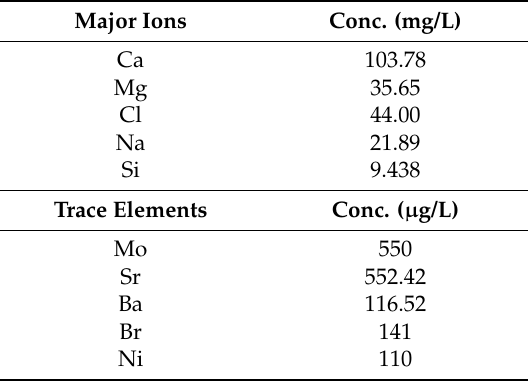
Table 3. The concentration of the selected dissolved ions in Well No. 5.